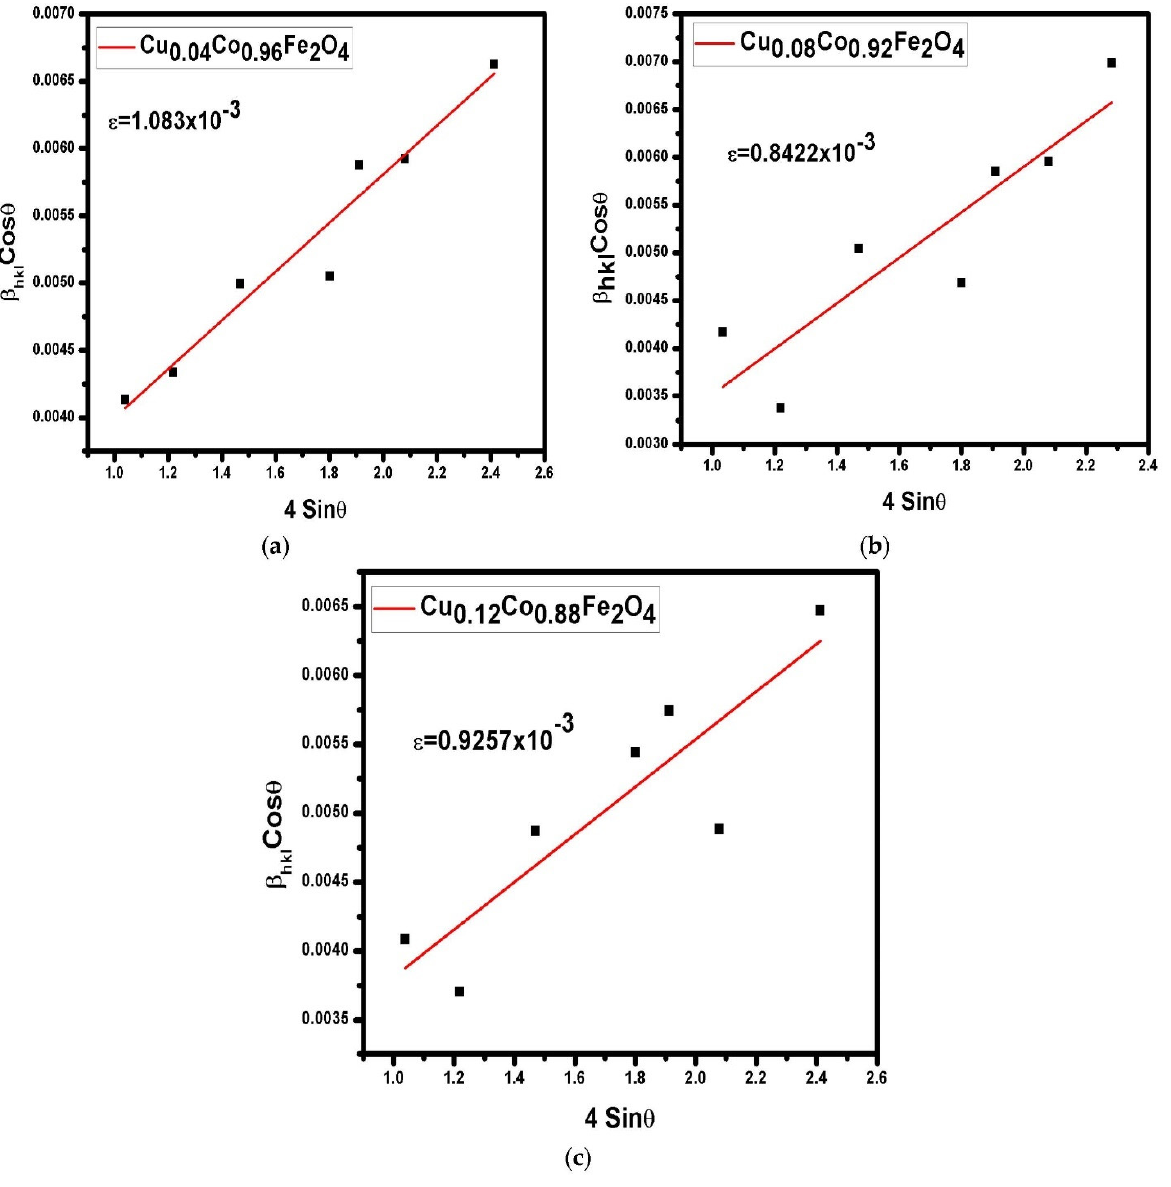
Figure 2. W–H plots of CFO NPs doped with different concentrations of Cu 2+ ions. ( a